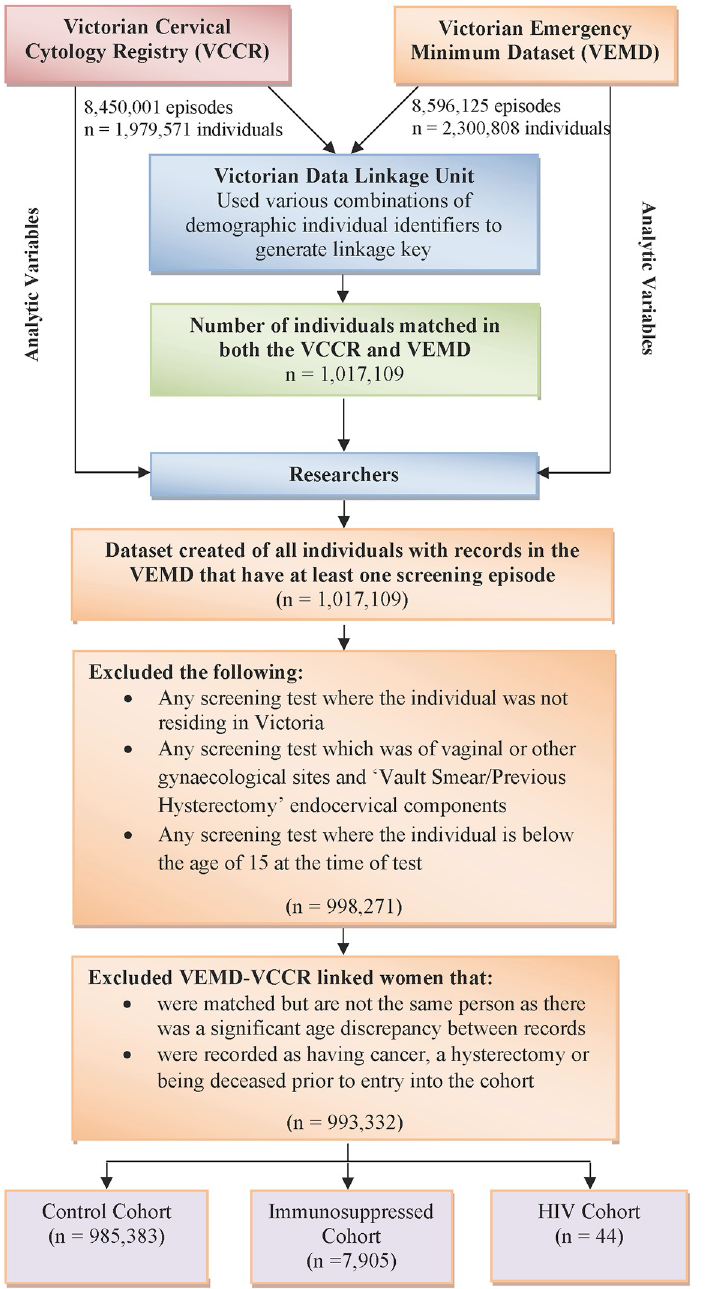
Fig 1. Flowchart of data linkage process and exclusions for analysis. abnormalities (23.84 vs 6.26 per 1,000 person-years, AHR = 3.43, p = 0.001) and low-grade cytological abnormalities (48.46 vs 19.99 per 1,000 person-years, AHR = 2.23, p = 0.003). SLE/MCTD Females with SLE/MCTD had significantly higher rates of high-grade histological abnormali- ties (5.57 vs 3.76 per 1,000 person-years, AHR = 1.47, p = 0.033), significantly higher rates of